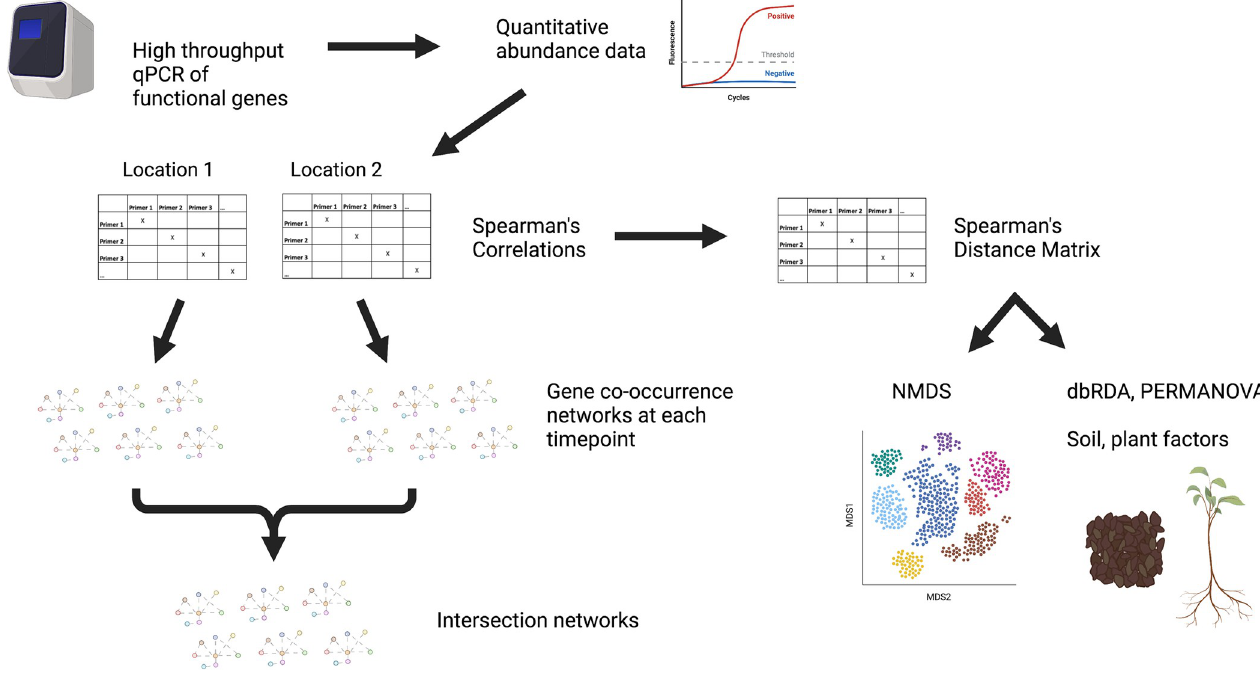
Fig 1. Data collection and analysis